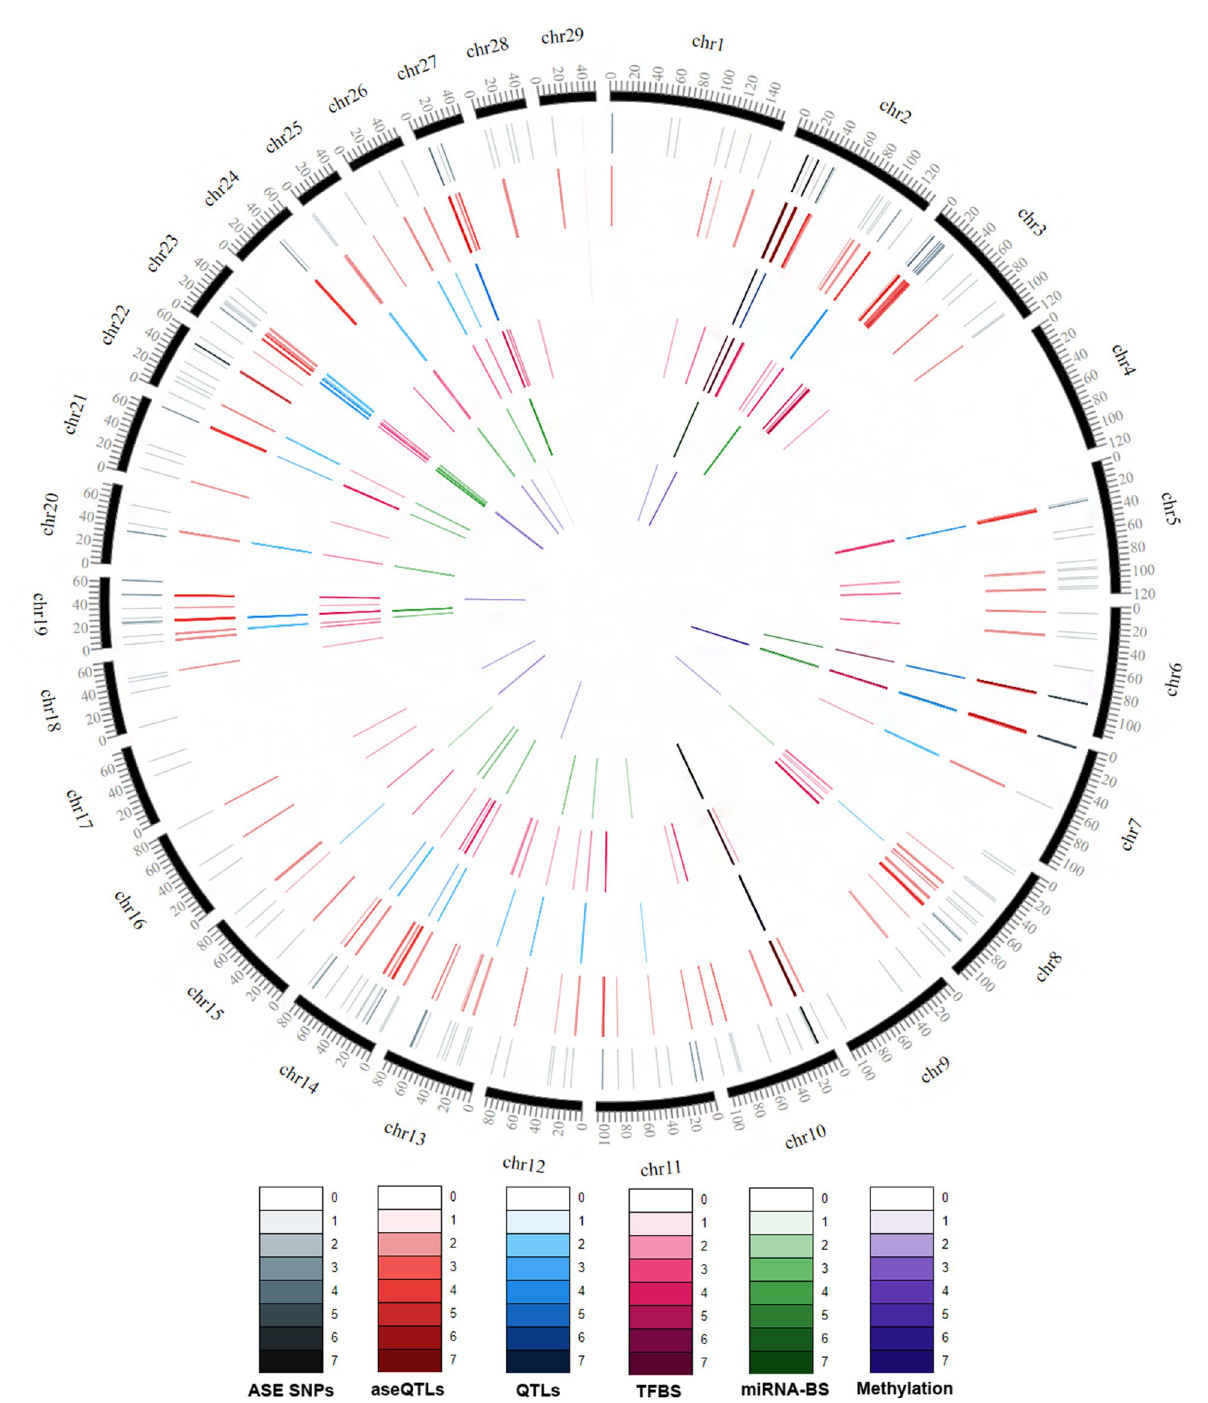
Figure 1. SNPs and aseQTLs distribution through the bovine chromosomes, overlap with previous QTL studies and predicted aseQTL regulatory mechanisms (TFBS, miRNA binding site, or methylated site). ASE SNPs: SNPs in transcripts with allele-specific expression, only the ASE SNPs with significant aseQTLs are displayed. aseQTL: identified allele-specific quantitative trait loci (aseQTLs). Overlapped: aseQTLs that overlaps with previous GWAS data made from our group. TFBS: aseQTLs that possibly enable the TF binding in only one allele. miRNA-BS: aseQTLs that potentially modify miRNA binding sites in only one allele. Methylated: methylated aseQTLs. The color intensity increases with increasing SNPs density in the plot scale (1 bp windows). This figure was made using the software CircosVCF 82